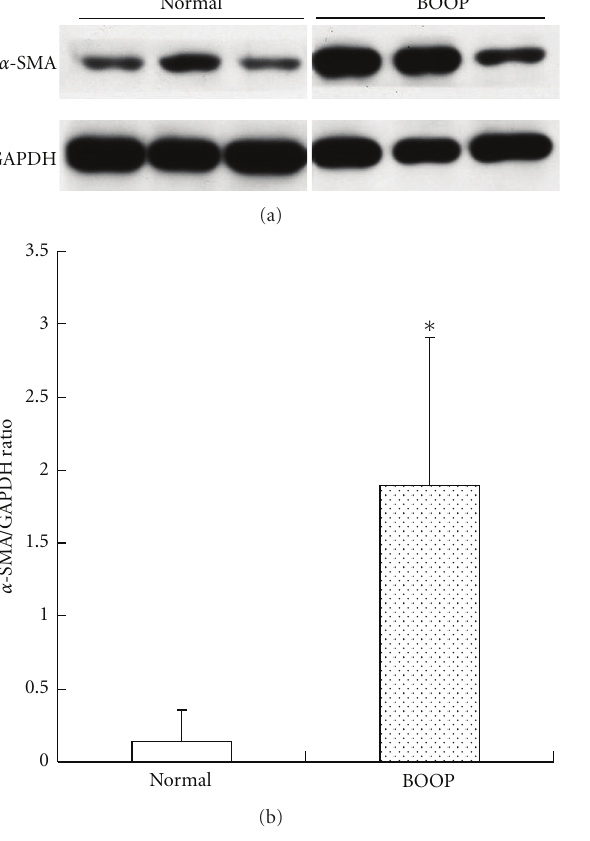
Figure 5: Quantitation of MFBs by alpha-SMA expression level. The Western blotting picture revealed that alpha-SMA expression level was increased in three representative BOOP cases (pigs) (a). The quantitative data were assayed from five cases (six lung sections in each case). Significant elevation of α -SMA expression in BOOP group was revealed ( P < . 05) (b). ∗ P < . 05 versus normal group ( n = 5, six replicates in each individual BOOP or normal